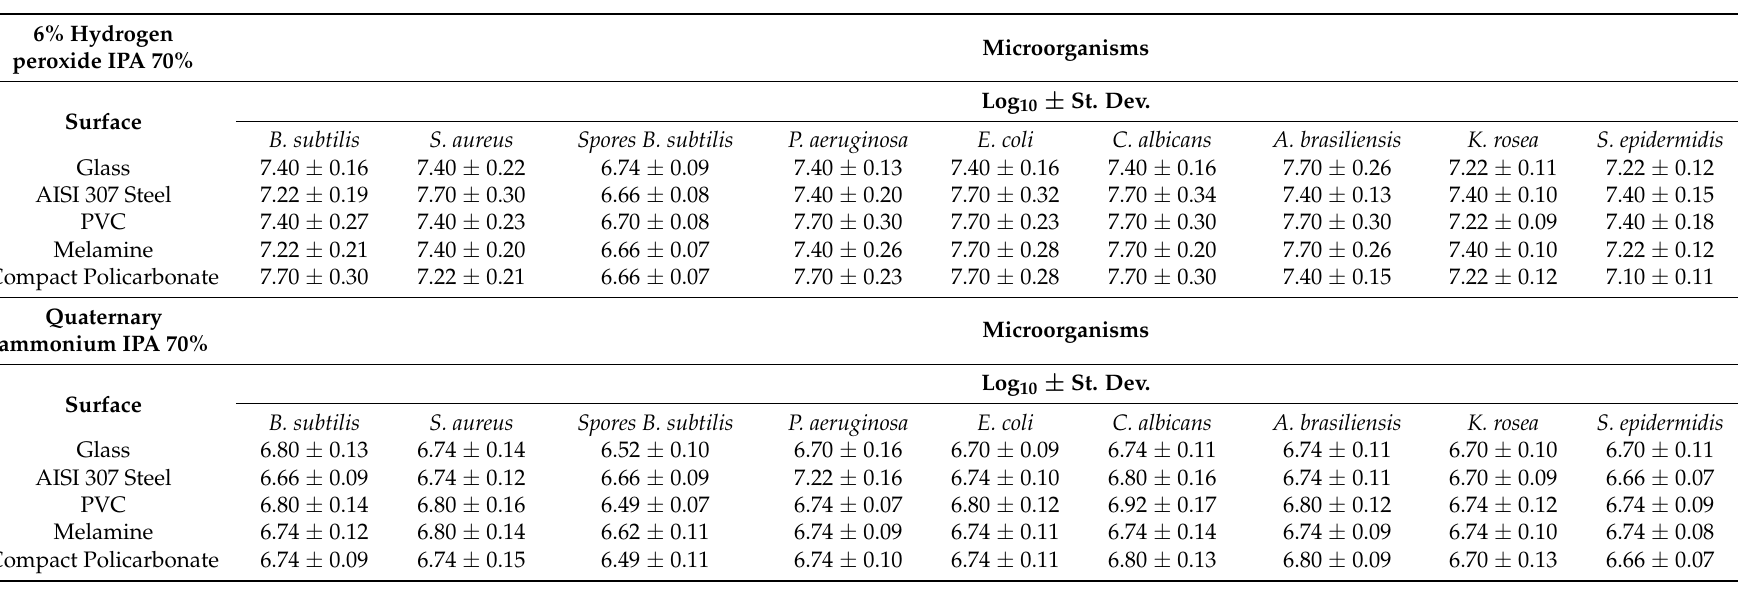
Table 3. Log 10 reduction index of surface contaminations determined after the disinfection procedure. Prior to the disinfection procedure, surfaces were contaminated with 10 7 –10 8 colony forming units (CFU)/mL. For each disinfectant, the contact time was 10